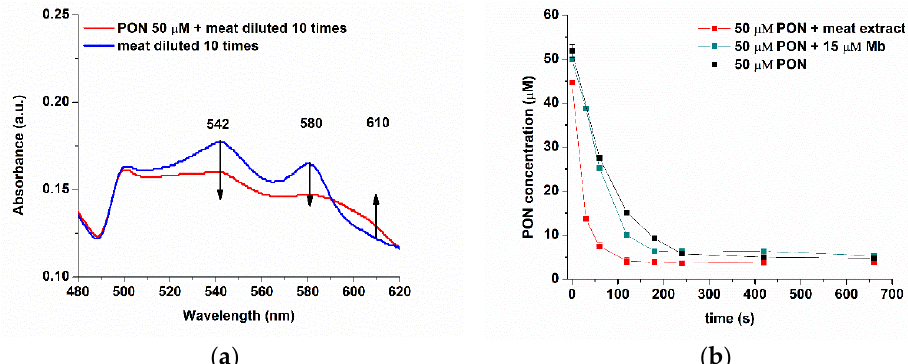
Figure 14. ( a ) UV-Vis spectra of meat diluted 10 times in PBS pH 9 in the presence of 50 µ M PON and in absence, during 12 min. ( b ) The graphs of concentration (from FIA-EC) over time for 50 µ M PON decay in the absence (black) or in the presence of 15 µ M Mb (cyan) or meat extract